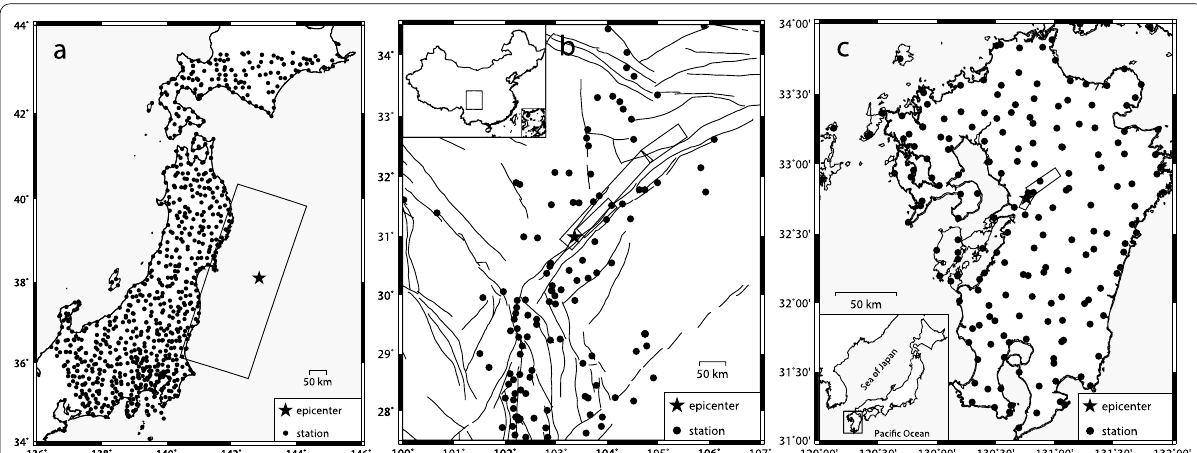
Fig. 1 Map of the earthquake and station locations. Stars show the epicenter, and dots show the seismic stations. The open rectangles show the surface projection of the fault plane. a 2011 Tohoku earthquake. b 2008 Wenchuan earthquake. The known faults are indicated in broken lines. The map of China is inserted in the top-left. c 2016 Kumamoto earthquake. The rectangle in the lower-left insert indicates the study area